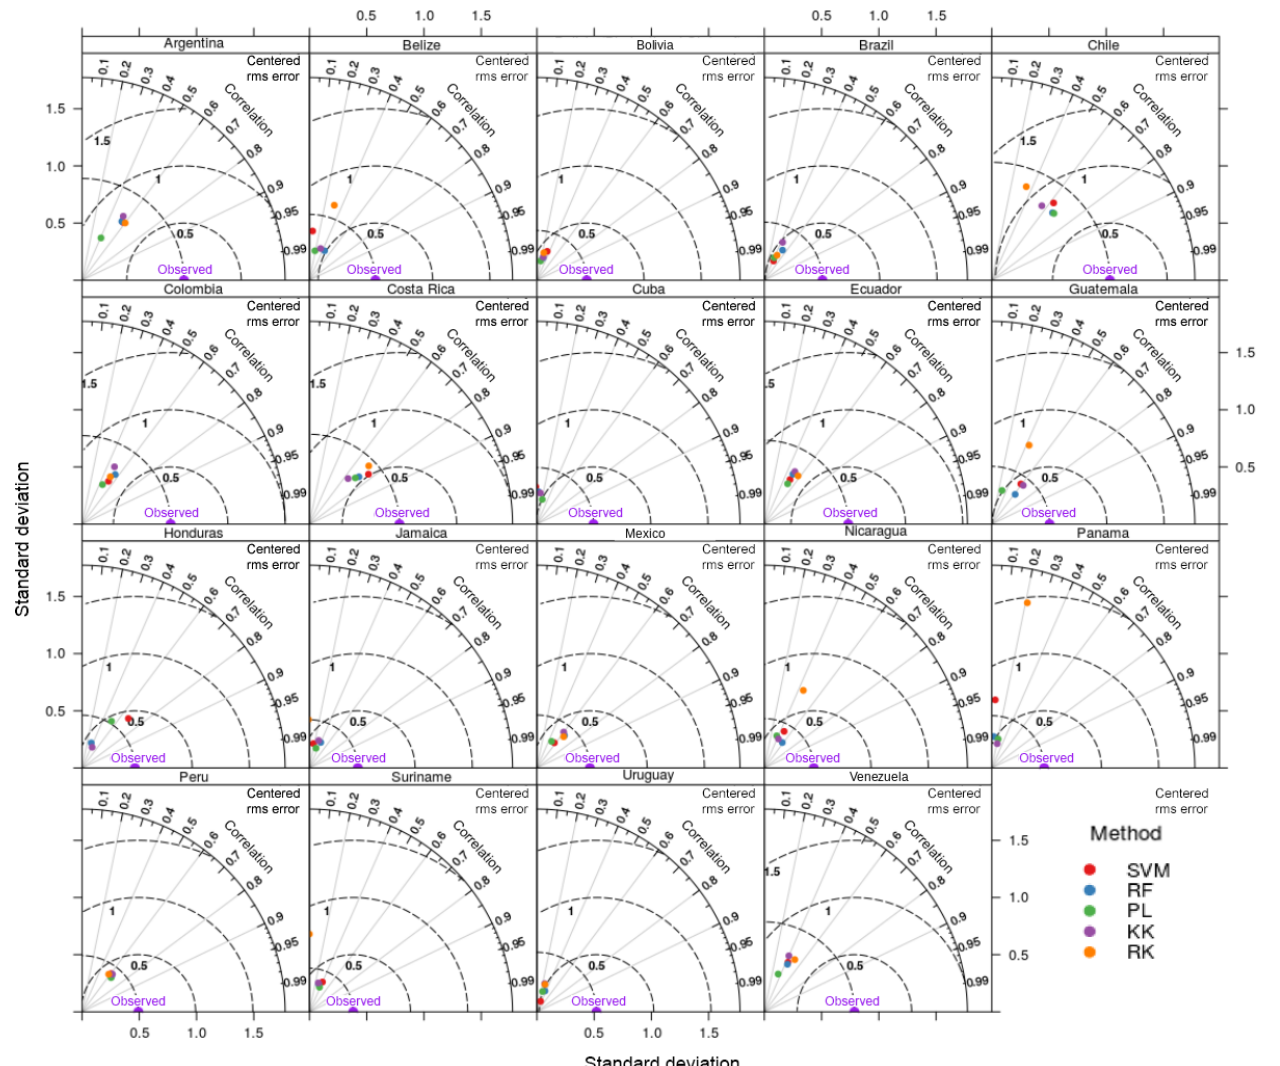
Figure 4. Taylor diagrams showing the performance of the five models evaluated for country-specific SOC estimates across Latin America. The position of each point/method varies from each dataset to another, suggesting that the predictive capacity changes when data character- istics are